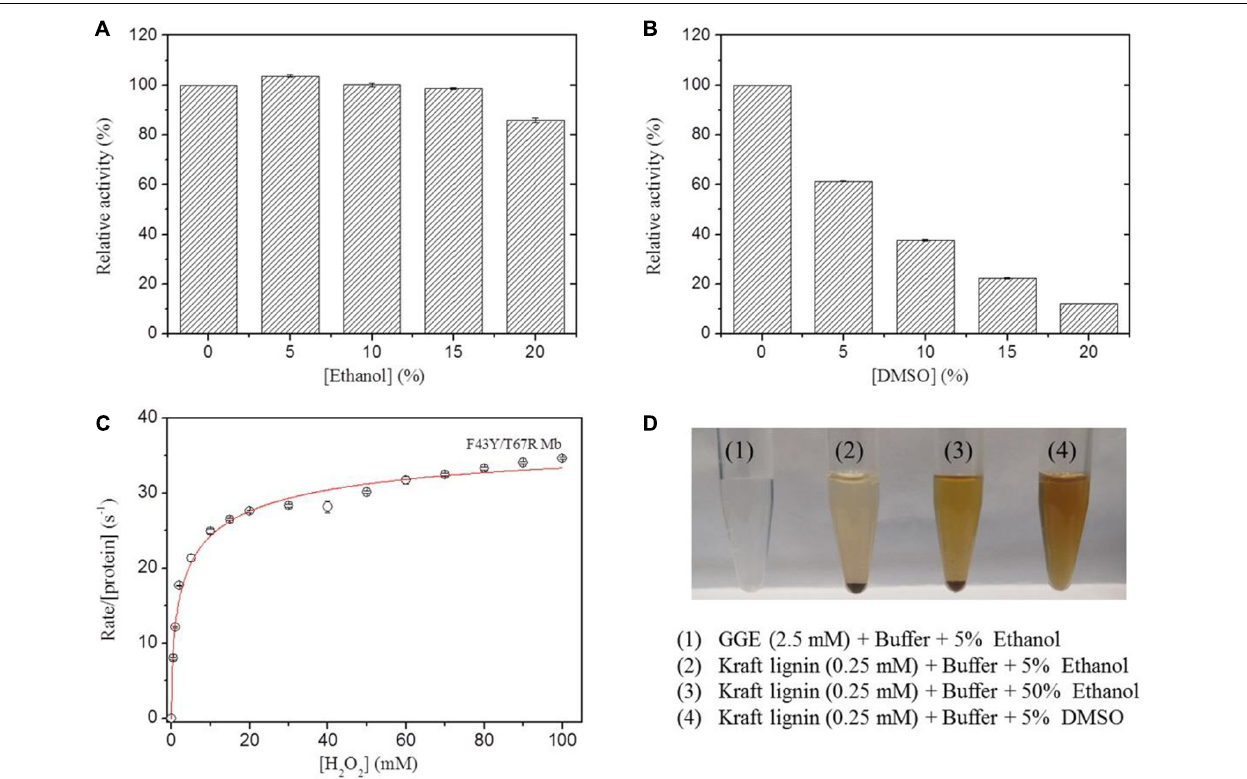
FIGURE 3 | Effects of ethanol (A) and DMSO (B) concentrations on the peroxidase activity of F43Y/T67R Mb, determined by measuring the oxidation of ABTS at pH 5.5 and room temperature. The activity in the absence of the organic solvent was taken as 100%. Values represent the means of three independent experiments (mean ± standard error). (C) Steady-state rates of H 2 O 2 -dependent oxidation of ABTS catalyzed by F43Y/T67R Mb, as a function of H 2 O 2 concentrations. The plot was fitted to the Hill equation. Reaction conditions: 2 µ M protein, 0.1 mM ABTS and 50 mM potassium phosphate buffer at pH 5.5. (D) Visual appearance of GGE (2.5 mM) and Kraft lignin (0.25 mM) dissolved in 5% (1–2), 50% ethanol (3), and 5% DMSO (4) for 10